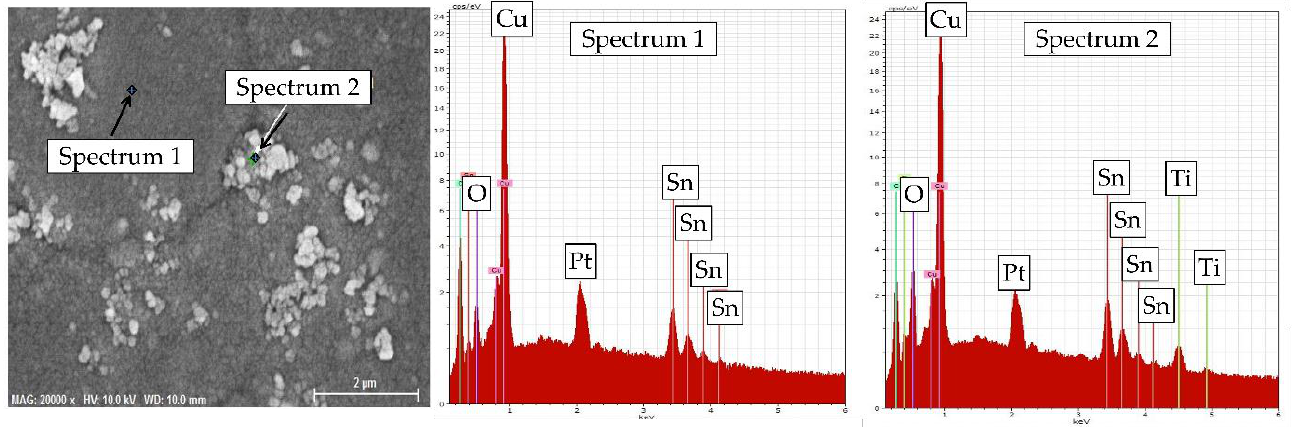
Figure 5. Point EDX analysis of Ti-1 coating surface. The signal from Pt on EDX spectra originates from the top sputtered layer. Table 2. EDX chemical composition (scans are 50 × 50 µm 2 ) of Cu – Sn and Cu – Sn – TiO 2 coatings deposited from sulfate electrolyte with varying TiO 2 content.